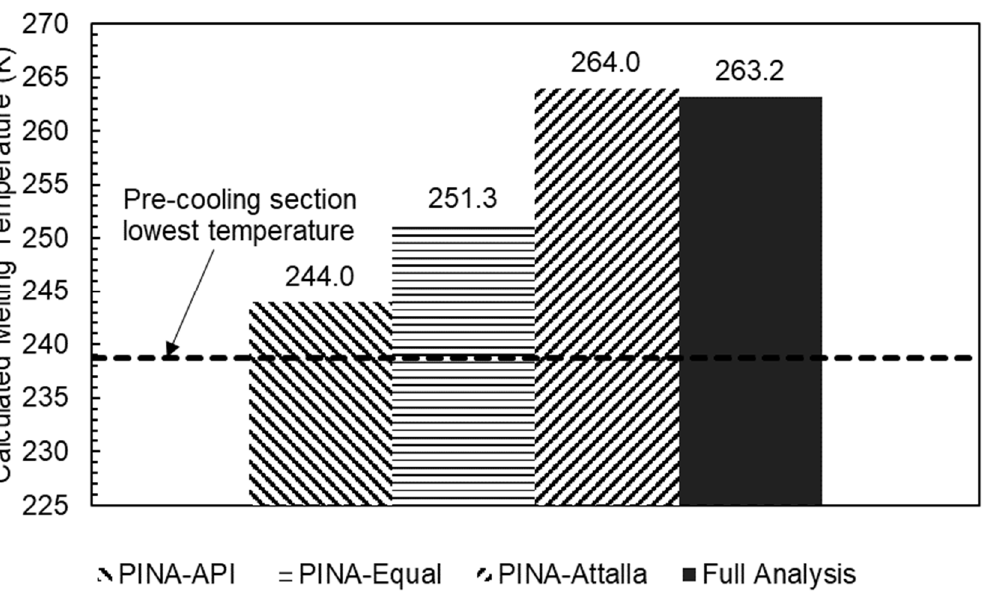
Figure 4. Comparison of the melting temperatures calculated using various PINA freeze-out pre- diction methods at a pressure of 6.307 MPa (900 psig) with that based on the full compositional characterization of the lean gas sample.